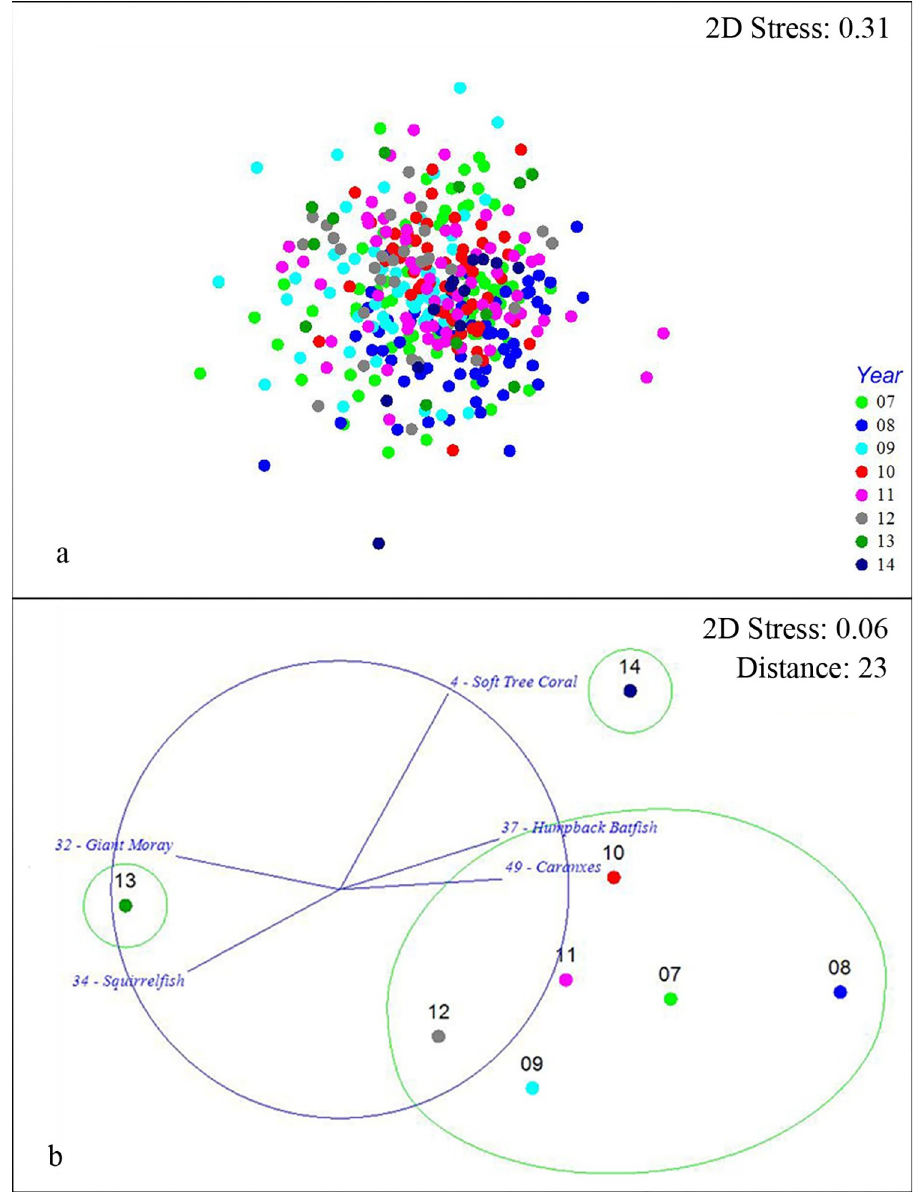
Fig 2. a) MDS plot of the SS Thistlegorm taxa presence/absence community structure over 8 years. Each point represents an individual questionnaire while the different shapes/colors indicate the different years. b) Centroidal MDS of SS Thistlegorm taxa presence/absence community structure variation over 8 years with overlayed vectors of aggregated best taxa and the indicated trajectories from 2007–2014. Each point represents the central location of the groups “Year”. The green circles surround the groups resulting from the hierarchical cluster